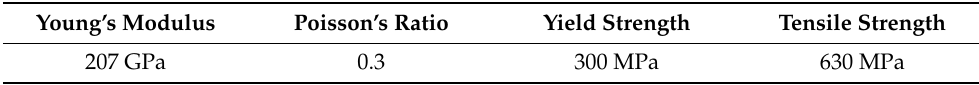
Figure 4. True stress true strain curve for steel API 5L X60. Table 1. Main mechanical properties of API 5L X60 steel.